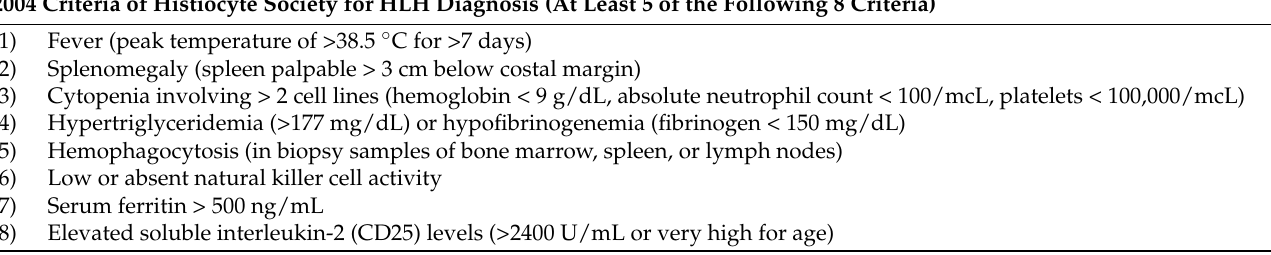
Table 1. 2004 criteria of Histiocyte Society for HLH diagnosis.